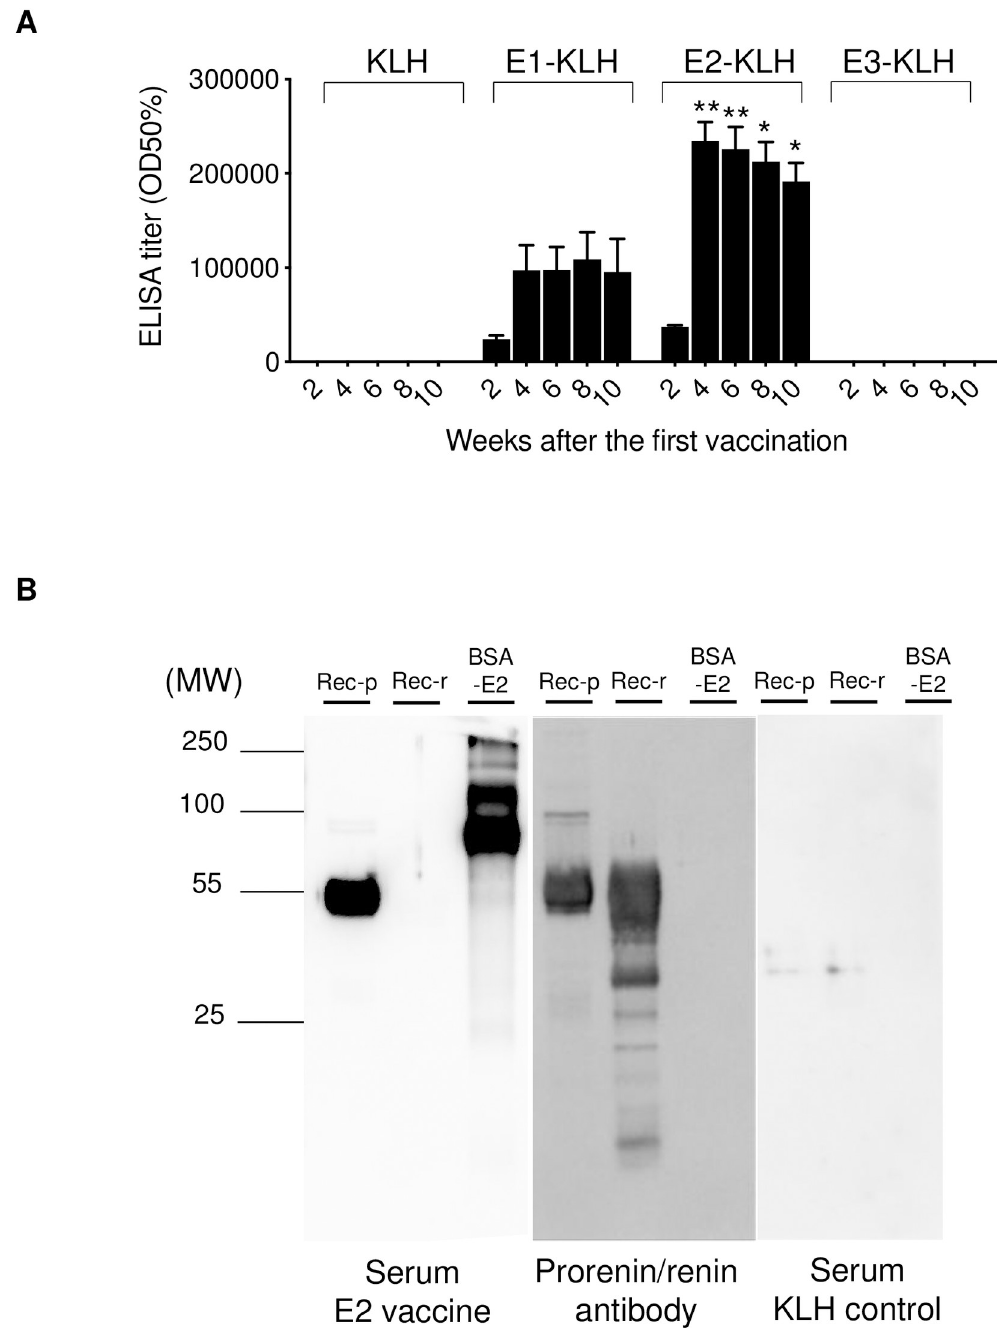
Fig 2. (A) Antibody titer in mice inoculated with E1 conjugated to KLH(E1-KLH), E2-KLH, E3-KLH, or KLH (unconjugated KLH as control) (n = 6 in each) (mean ± SE) measured by ELISA. � p < 0.05 vs E1. (B) Confirmation of specific binding of E2 to prorenin. Sera were collected from mice inoculated with E2-KLH or KLH. A commercially available anti-prorenin/renin antibody was used as a positive control. BSA, bovine serum albumin; ELISA, enzyme-linked immunosorbent assay; KLH, keyhole limpet hemocyanin; MW, molecular weight; Rec-p, recombinant prorenin; Rec-r, recombinant renin.